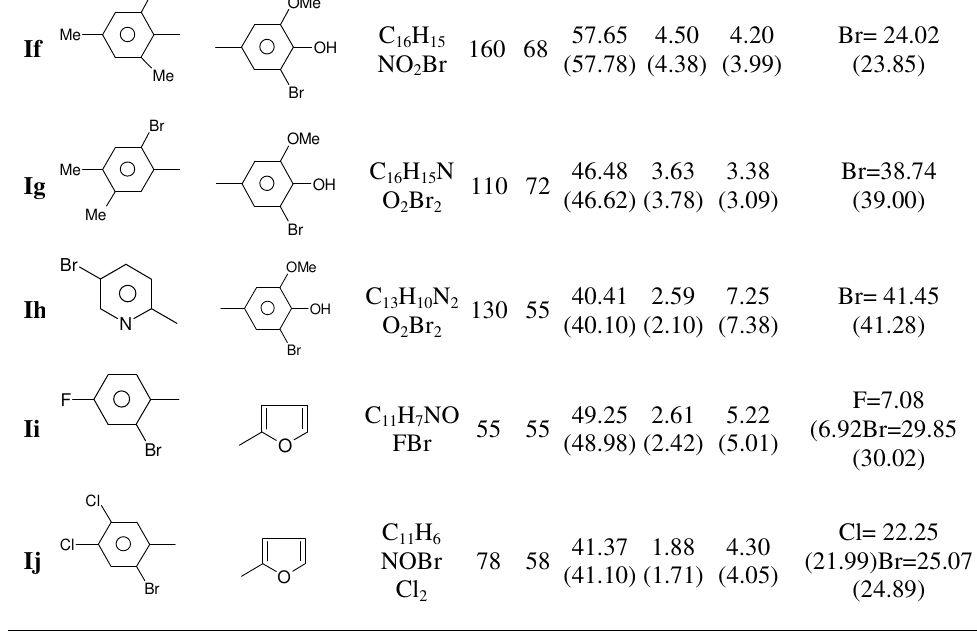
Table 2. IR (cm -1 ) and 1 HNMR ( δ , ppm) spectral data of halo substituted Schiff